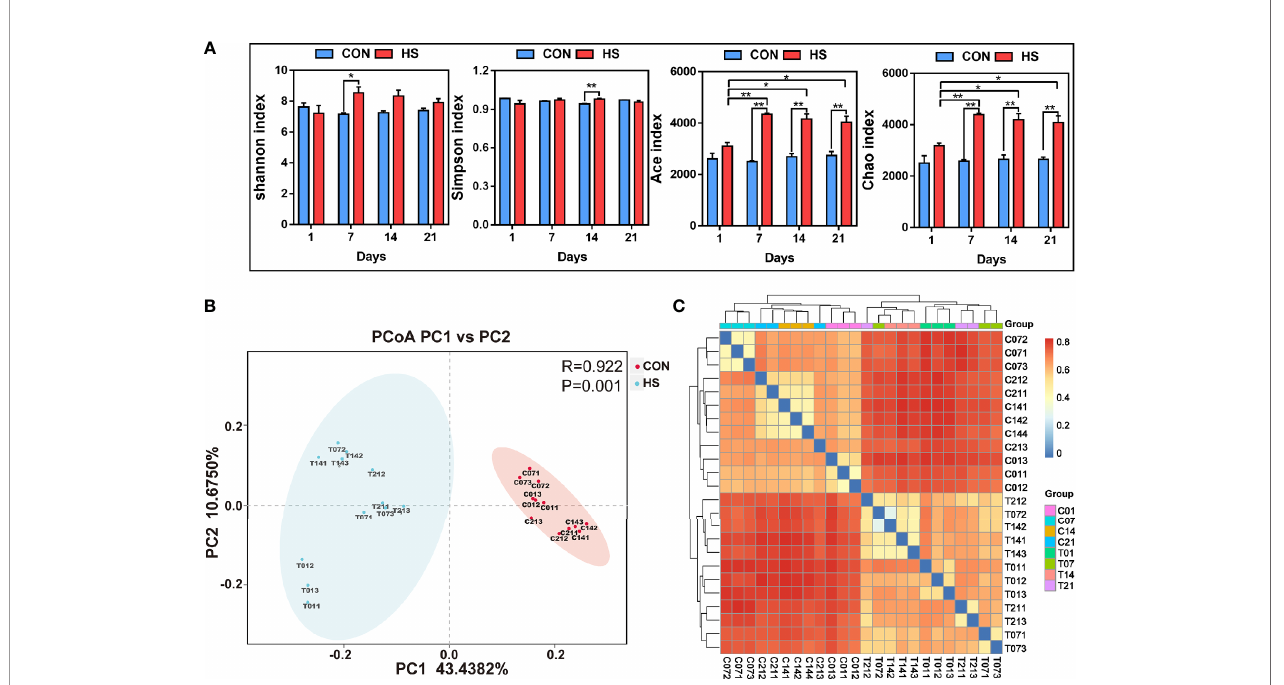
FIGURE 6 | The effect of heat stress on the microbial diversity of pig colon. CON and C indicate no heat stress group, HS and T indicate heat stress treatment, 1, 7, 14, 21 indicate day 1, 7, 14, and 21 groups respectively, n = 3; “ * ” indicates p < 0.05, and “ ** ” indicates p < 0.01. (A) inter-group Alpha diversity analysis of Shannon index, Simpson index, Ace index and Chao Index; (B) principal component analysis between samples; (C) species composition heat map between